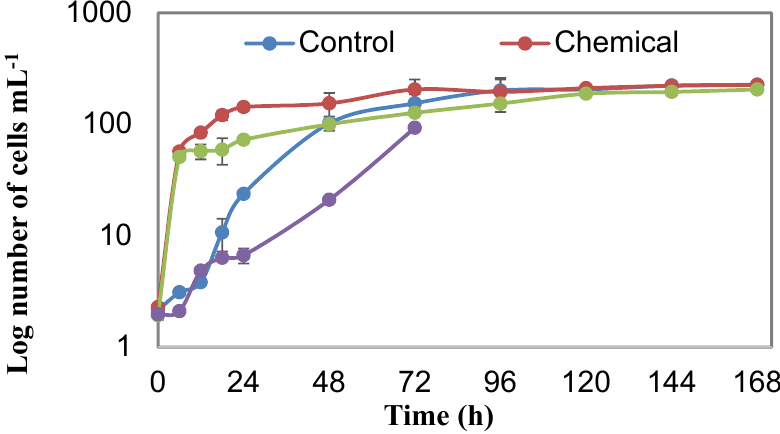
Figure 2. Growth of R. glutinis in carbohydrate-rich food waste (CRFW)